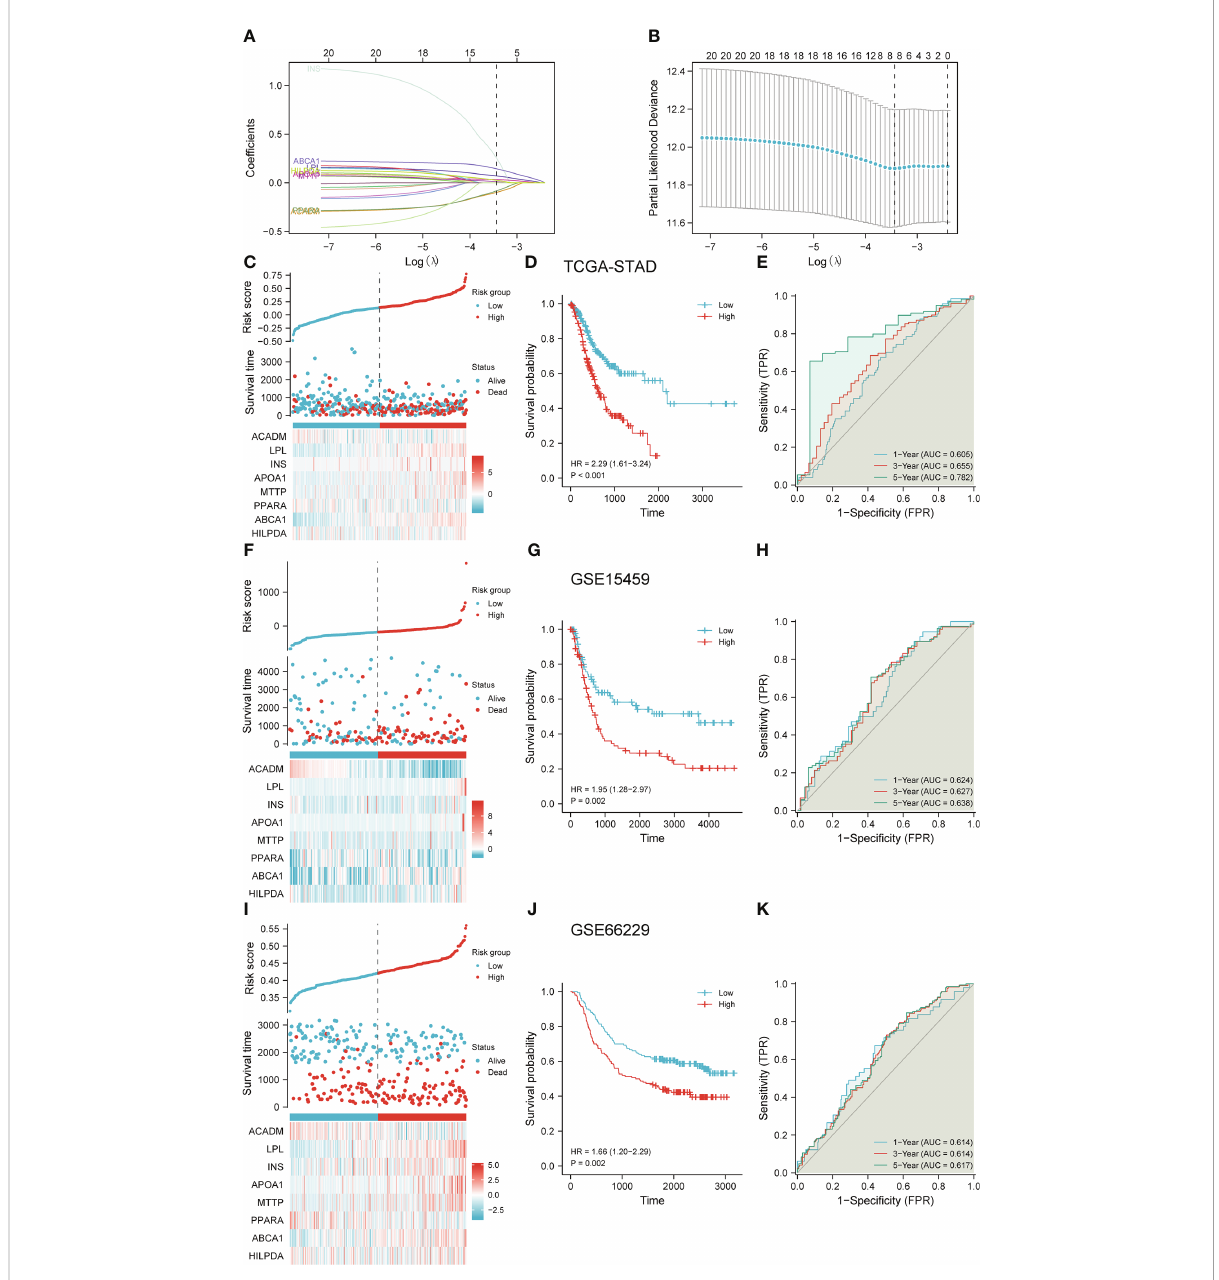
FIGURE 6 Construction and validation of the Lasso regression model. (A) Trajectory plots of variables for Lasso regression analysis. (B) Screening of coef fi cients for Lasso regression analysis variables. (C – E) Construction and evaluation of a risk prediction scoring system in the TCGA-STAD cohort. (F – H) Validation and evaluation of risk prediction scoring systems in the GSE15459 cohort. (I – K) Validation and evaluation of risk prediction scoring systems in the GSE66229